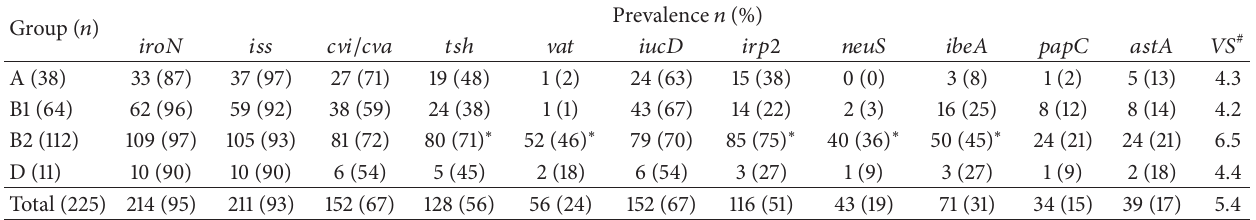
Table 1: Distribution of 225 E . coli strains according to the phylogenetic group and presence of virulence genes.